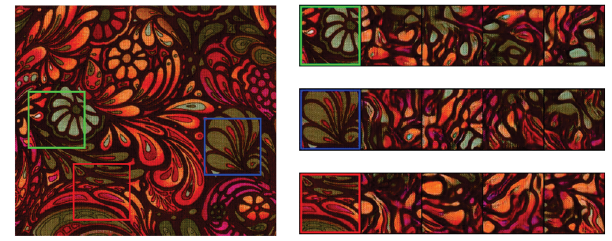
Fig. 12 Limitation example. When the input texture includes elements of scale larger than our crop size of 128 × 128, they are not preserved in the generated samples.